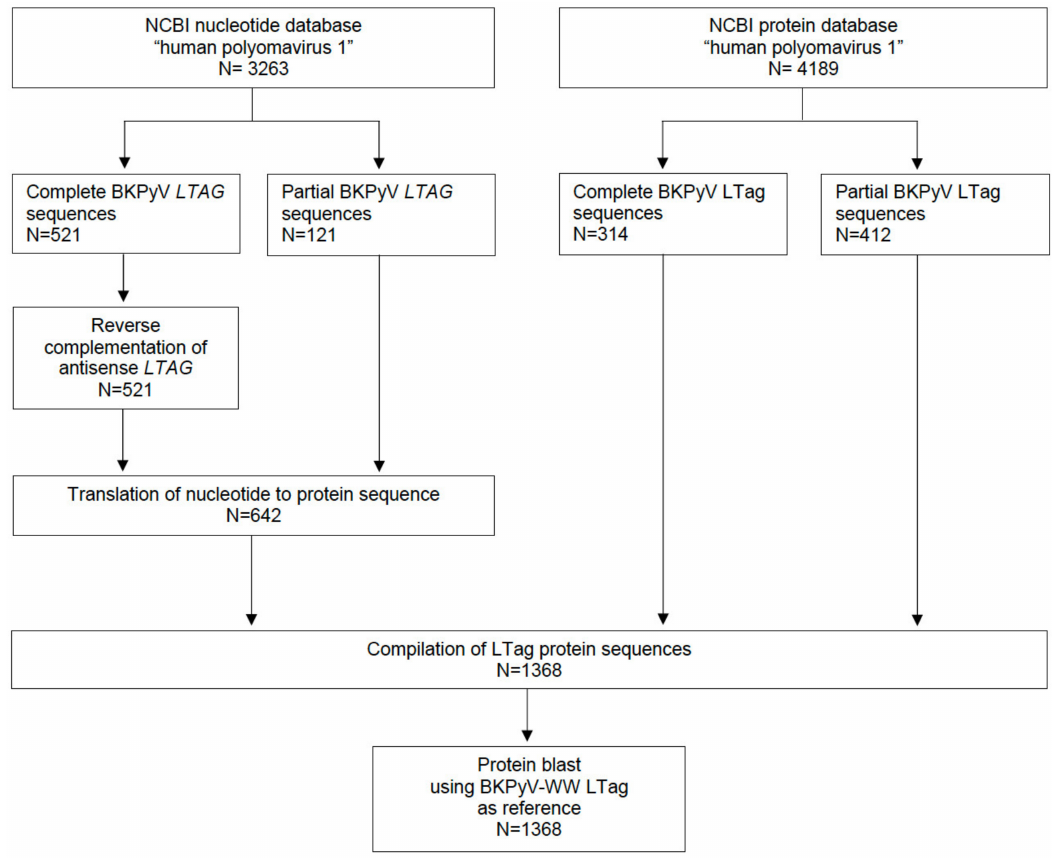
Figure 1. Bioinformatic analysis flowchart. BKPyV large tumor antigen (LTag) sequences were downloaded from the NCBI nucleotide and protein database (as of 13 November 2020). Nucleotide Scheme 12. QIAGEN, Hilden, Germany) and the LTag BKPyV-WW sequence as reference (BKPyV subtype Ib-1; acc.